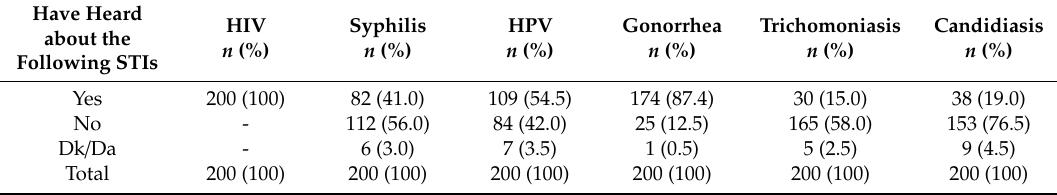
Table 2. Respondents’ knowledge about the sexually transmitted infections (STIs).